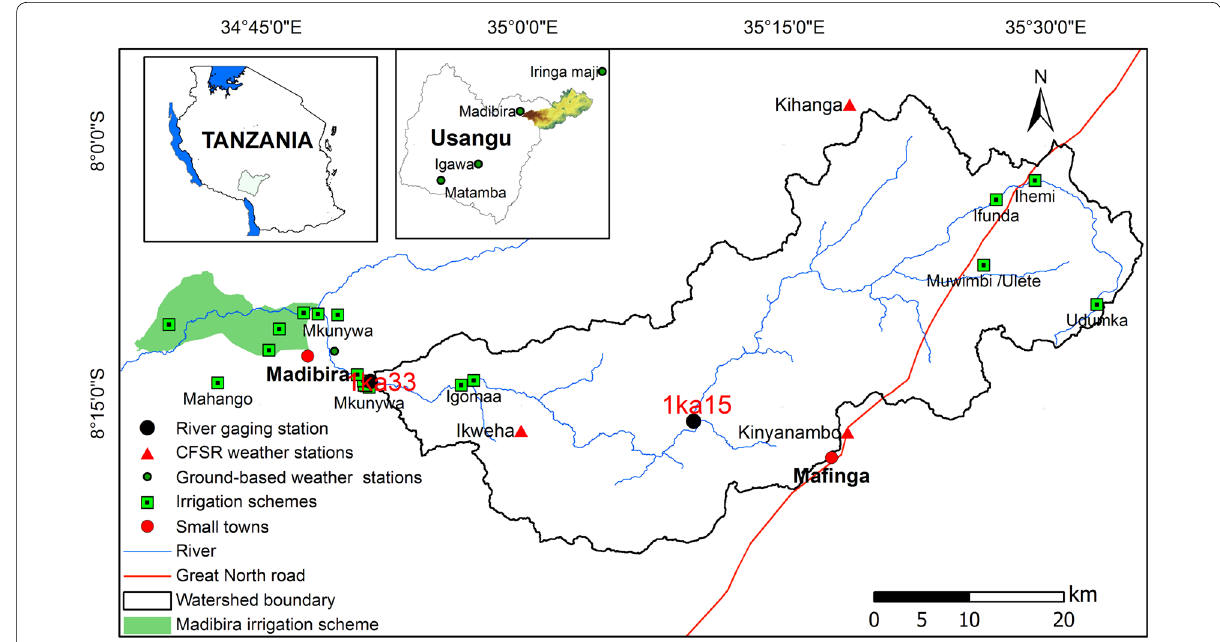
Fig. 1 Location of Ndembera watershed showing major farm and irrigation schemes